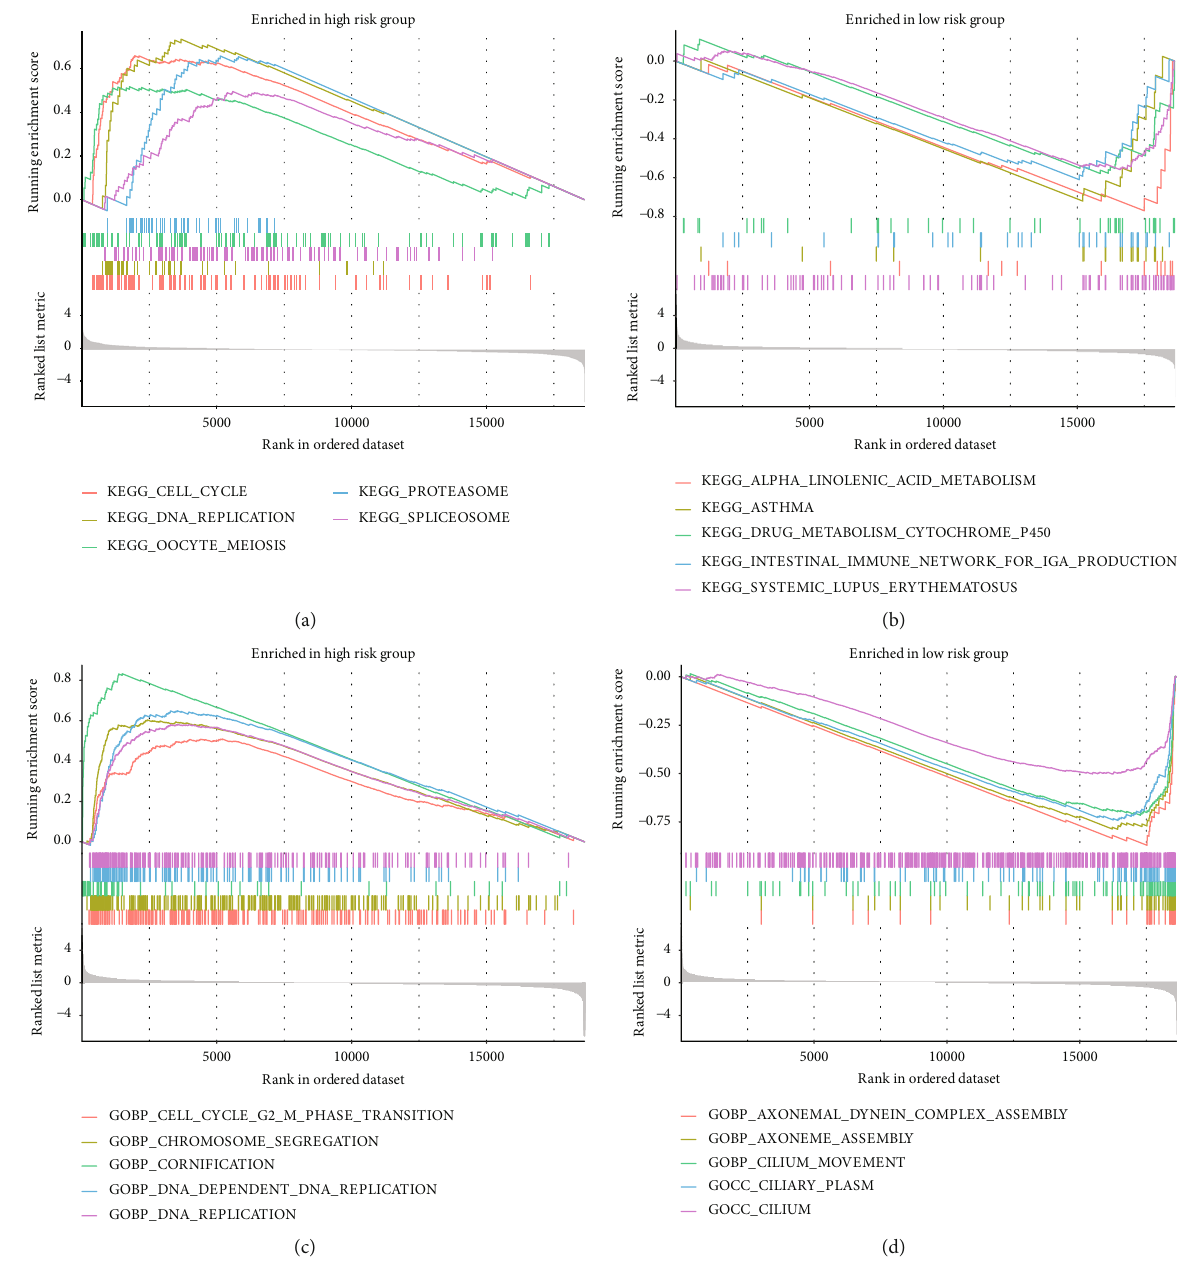
Figure 6: The result of GSVA. (a and b) The result of KEGG analysis. (c and d) The result of GO analysis. (a and c) High-risk group. (b and d) Low-risk